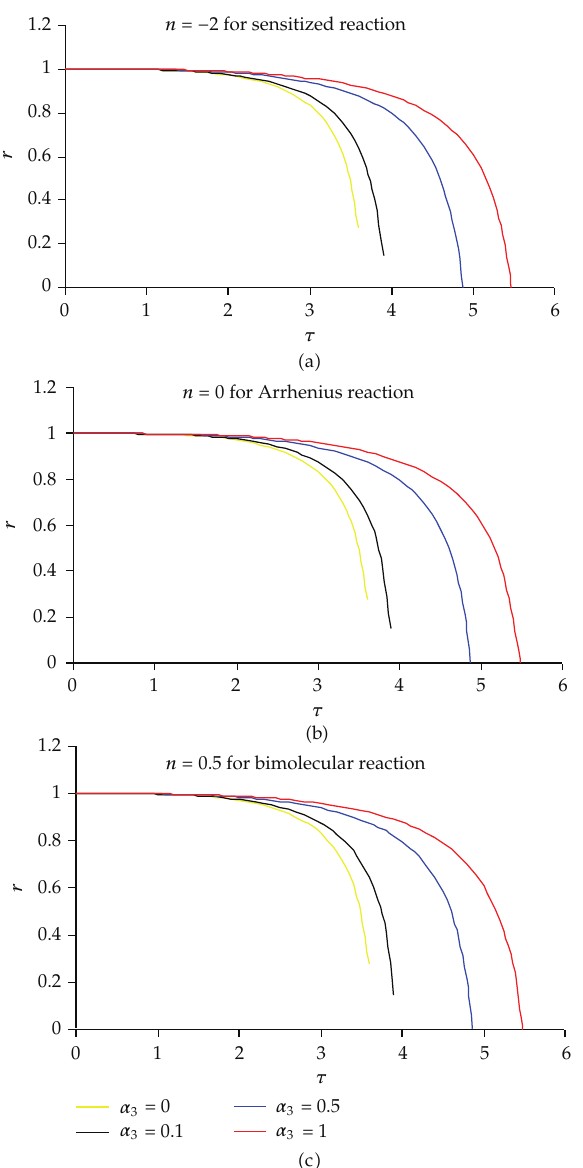
Figure 3: Variation of dimensionless droplet radius with interphase heat exchange parameters when n (cid:7) {− 2 , 0 , 0 . 5 }